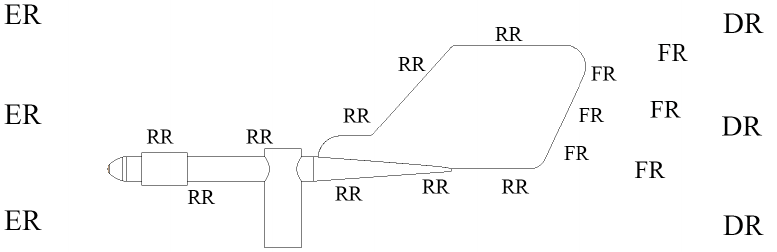
Figure 2. Weather vane flow regions: ER—Euler region, RR—RANS region, FR—Focus region, DR—Departure region.